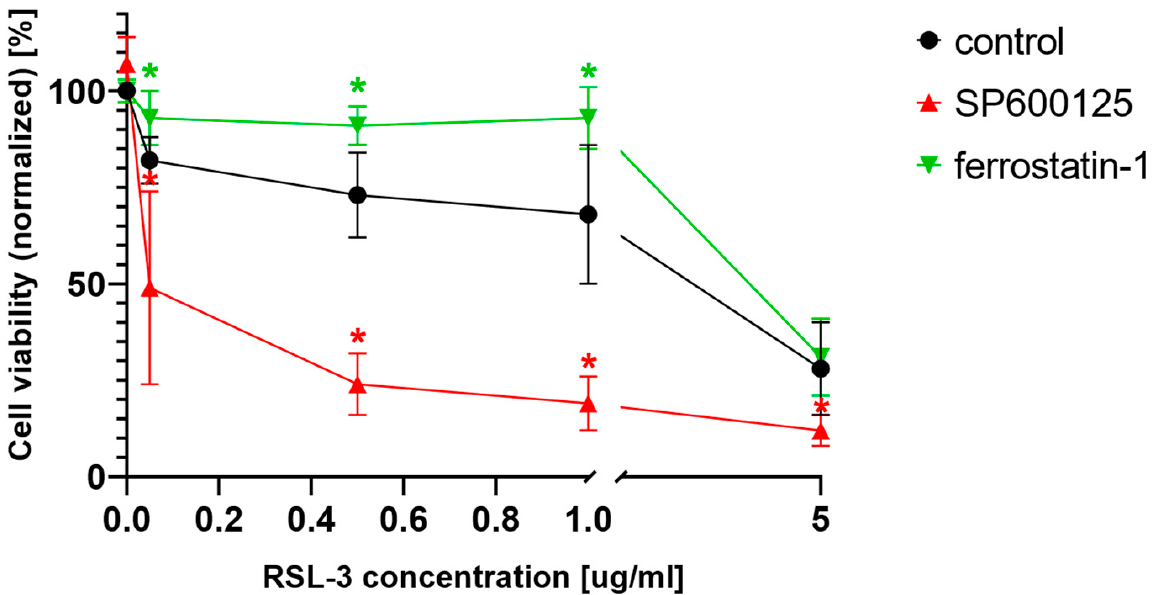
Figure 6. Pharmacological inhibition of JNK activity enhances the effect of ferroptosis inductor, RSL-3, in MIA PaCa-2 cells. MIA PaCa-2 cells were treated on a 96-well plate for 24 h with the ferroptosis- inducing compound, RSL-3 (0.05–5 µ g/mL). RSL-3 treatment, within all applied concentrations, significantly decreased cell viability. Co-treatment with JNK inhibitor, SP600125 (5 µ M), significantly decreased cell viability compared to only RSL-3 treatment. Ferroptosis inhibitor, ferrostatin-1 (10 µ M), inhibits ferroptosis inducement at lower RSL-3 concentrations. Cell viability was measured by MTT assay. Data are normalized to untreated control and each data point represents the average ± SD from at least three independent experiments. * Significantly different ( p < 0.05) from group control (RSL-3 treated without co-treatment).